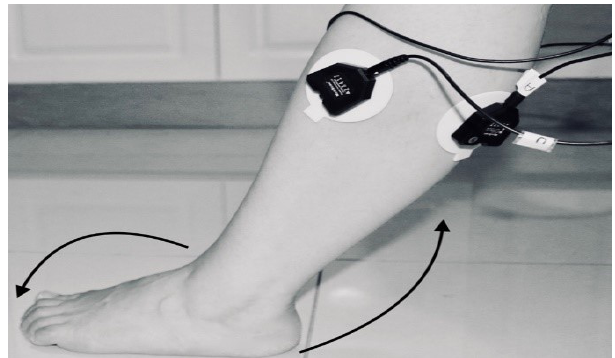
Figure 8. Knee Flexion with Extension Planter